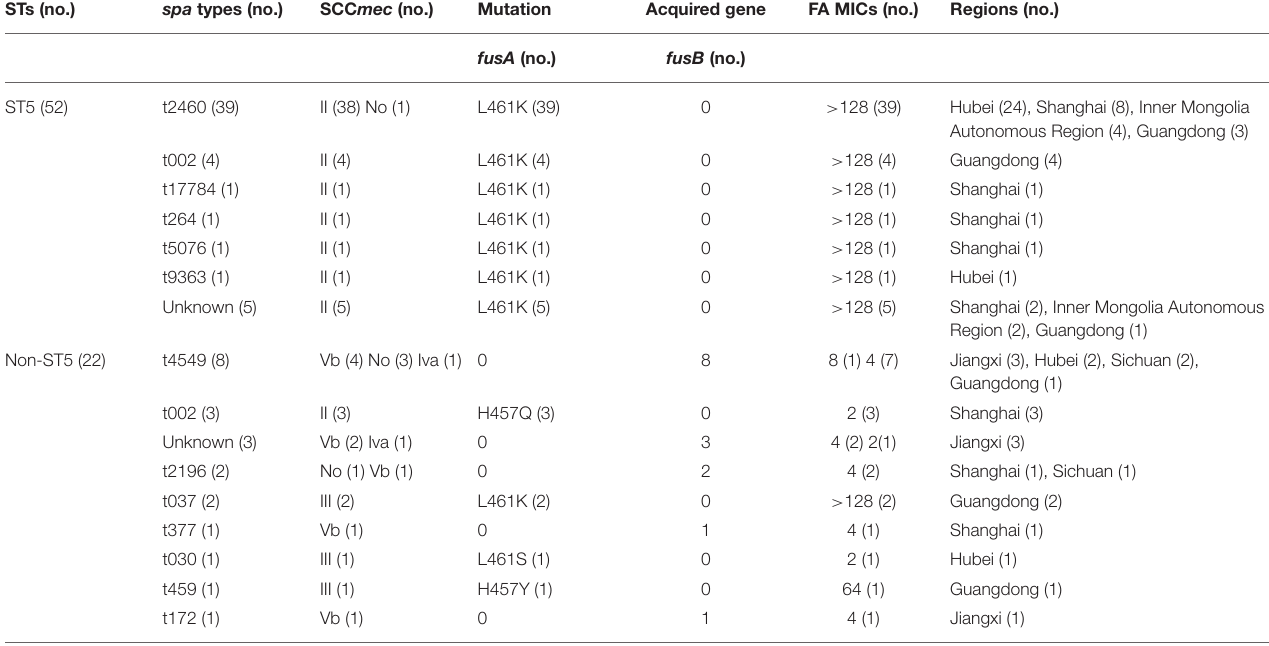
TABLE 3 | Molecular characteristics and resistant determinants among FA-resistant MRSA isolates. STs